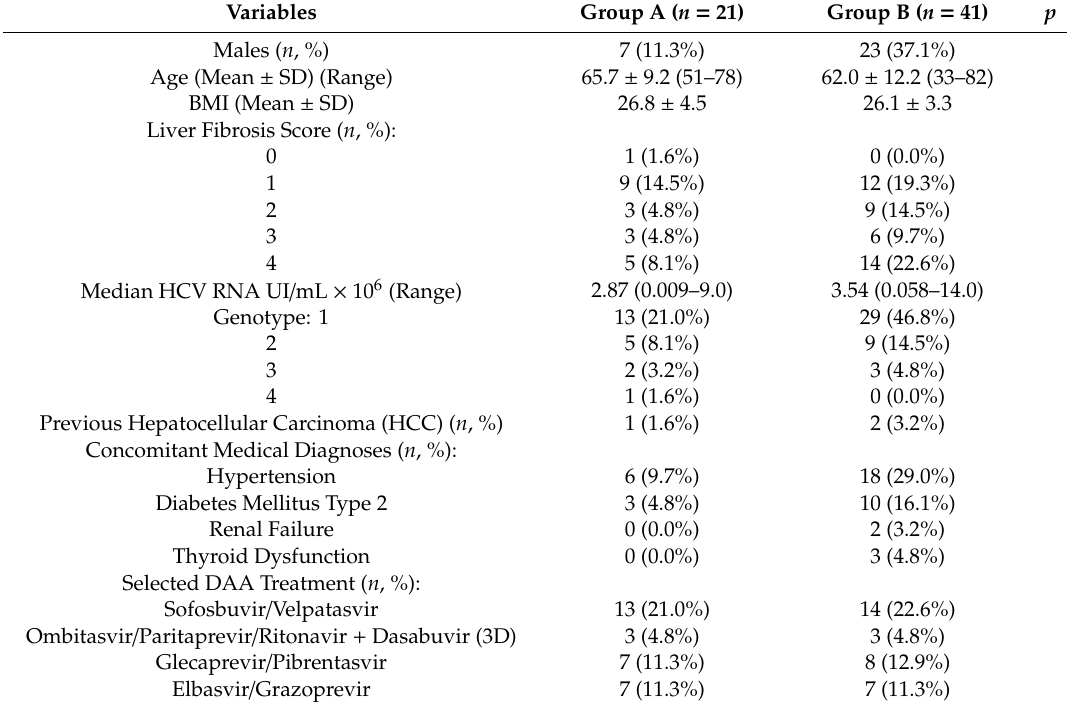
Table 1. General characteristics of enrolled chronic hepatitis C (CHC) patients with (Group A) and without (Group B) a current or lifetime psychiatric history in basal